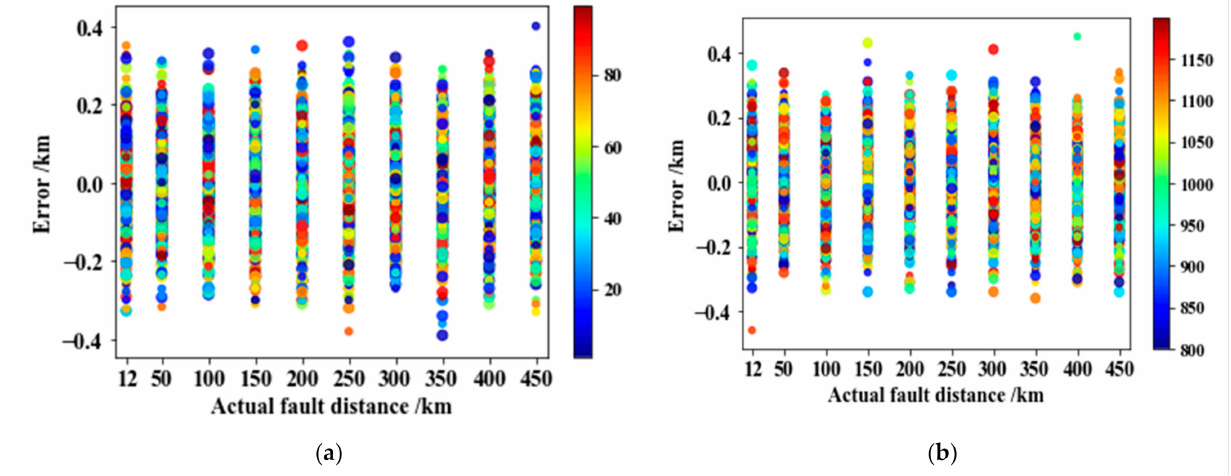
Figure 18. Test results of CNN-LSTM with six LSTM layers; ( a ) LIF and ( b )